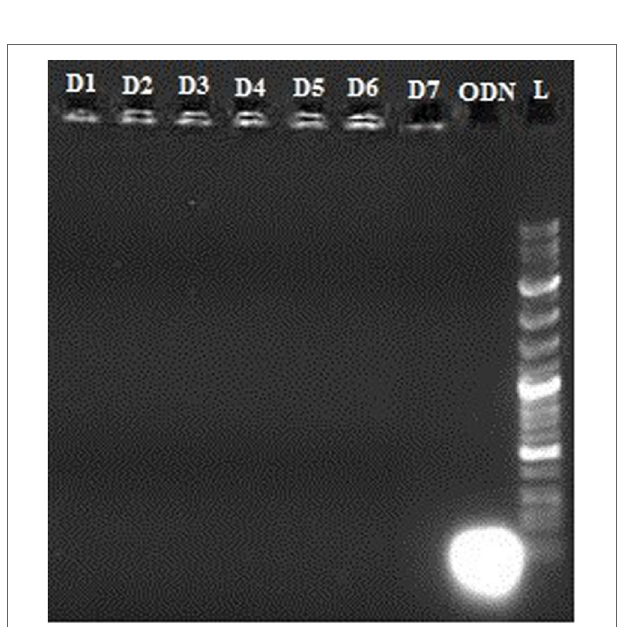
FigUre 4 | In vitro release profile of monophosphoryl lipid A, resiquimod, and ovalbumin from poly(lactic-co-glycolic) acid nanoparticles over the time. The experiment was performed in PBS in 37°C. Indicated values are mean ( ± SD) of at least three